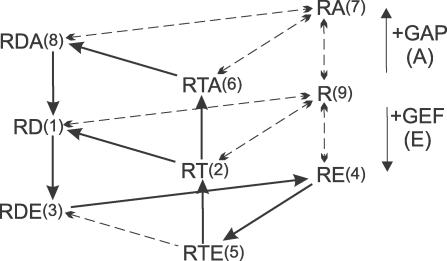
Reaction Scheme of the Small GTPase CycleThe three forms of the GTPase (RD, RT, and nucleotide-free R) (middle layer) form complexes with a GEF (E) (bottom layer) and a GAP (A) (top layer). Solid arrows indicate the main reaction fluxes. All reactions except GTP hydrolyses (2 → 1, 6 → 8, 5 → 3) are reversible. Numbering of the species is consistent with the reaction rate constants listed in Table 3. Free GTP (T), GDP (D), GEF, and GAP are not shown for simplicity.